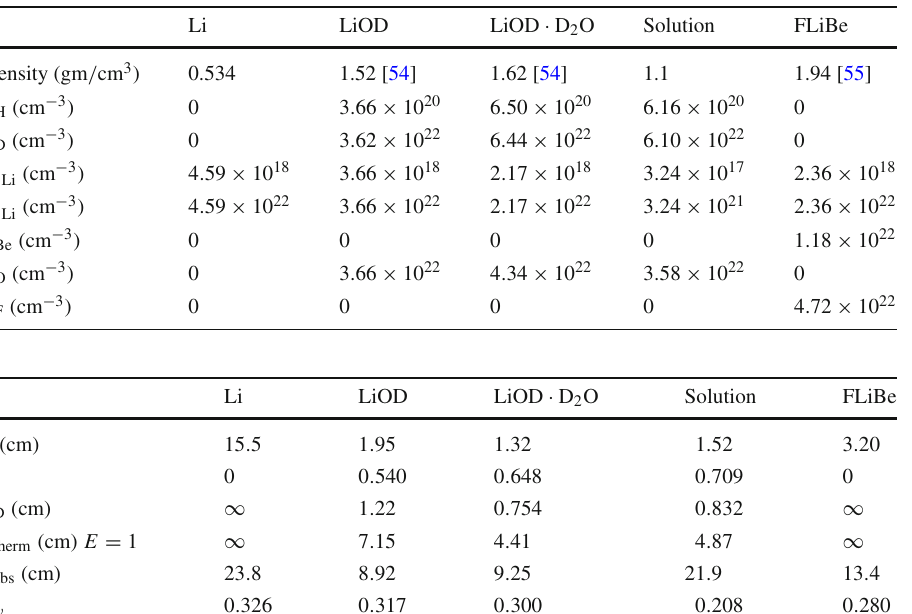
number densities in various converters. The densities have been rescaled from the original references to reflect the desired isotope compositions